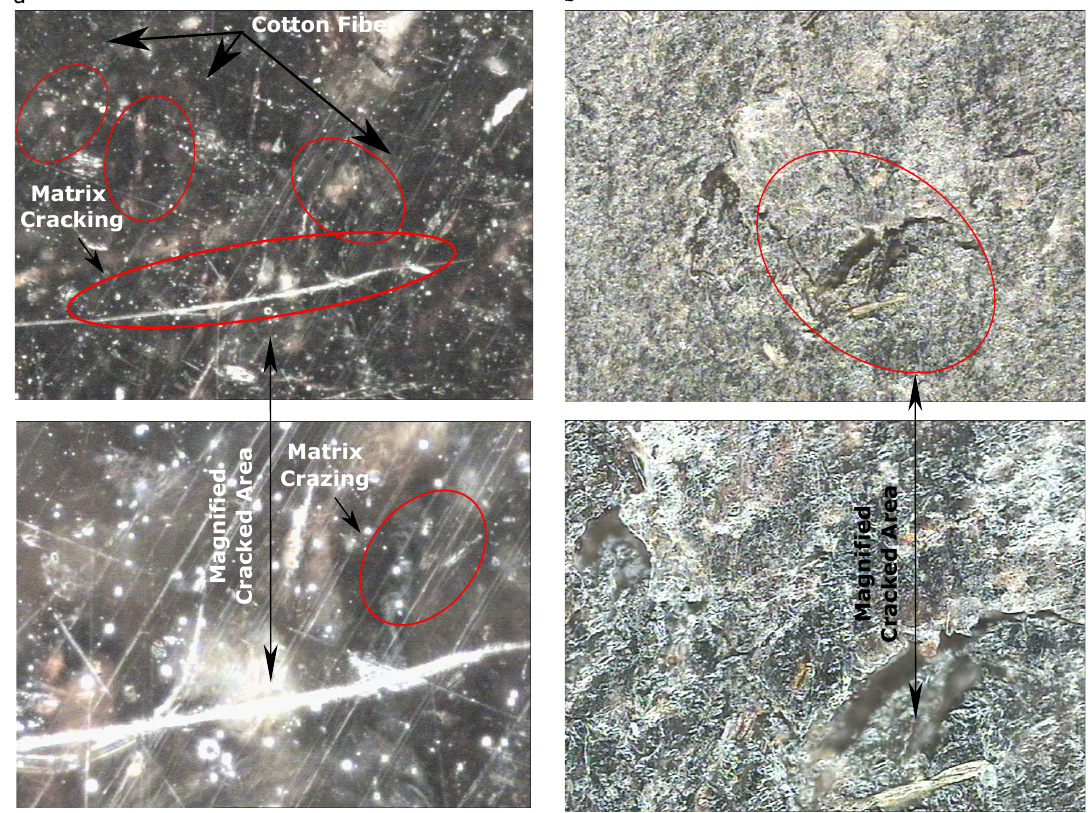
Figure 10. Representative samples (30% of filler addition) that show the surface of the material with 20 × (top) and 50 × magnification (bottom) taken after the tensile test and from the fracture surface for ( a ) PP/CF composites, and ( b ) PVC/CF